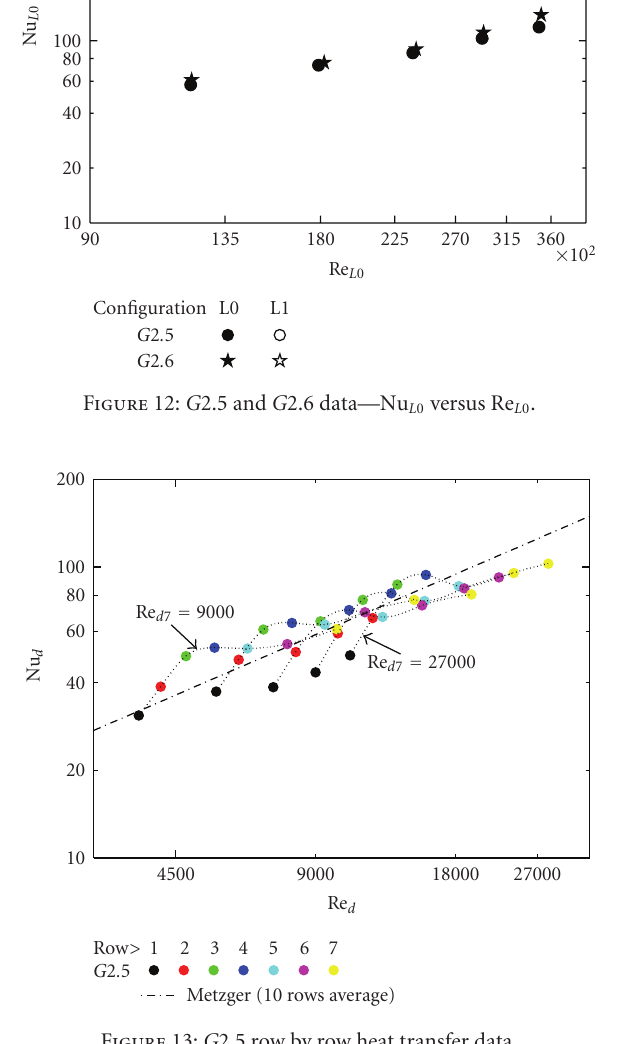
Figure 13: G 2.5 row by row heat transfer data.